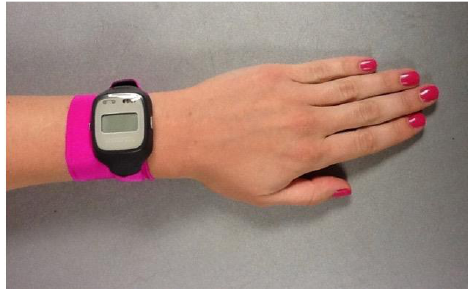
Figure 2. An actigraph watch secured with a Lycra band.